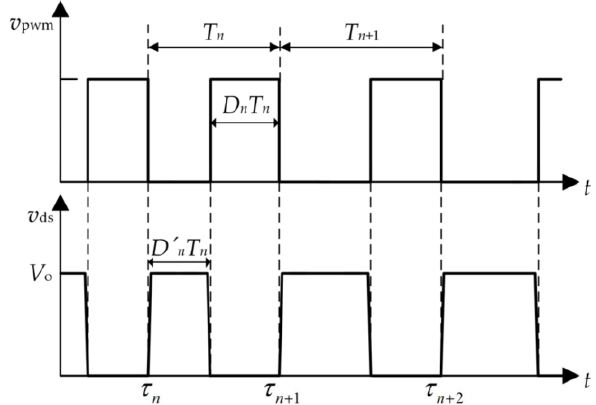
Figure 5. Waveforms of PWM and drain – source voltage.